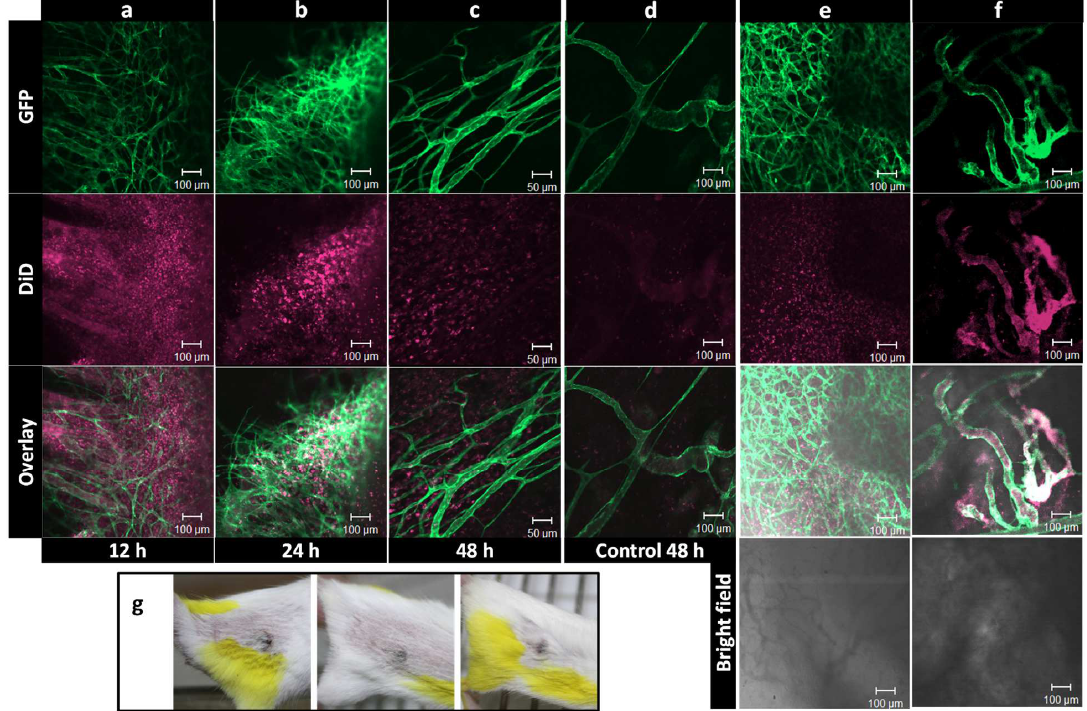
Figure 10. In vivo behavior of TAT-modified liposomes. Intratumoral behavior of DiD-labeled TAT- modified ( a – d ) or DiD-labeled plain liposomes ( e , f ) inside B16F0 tumors, using the dorsal